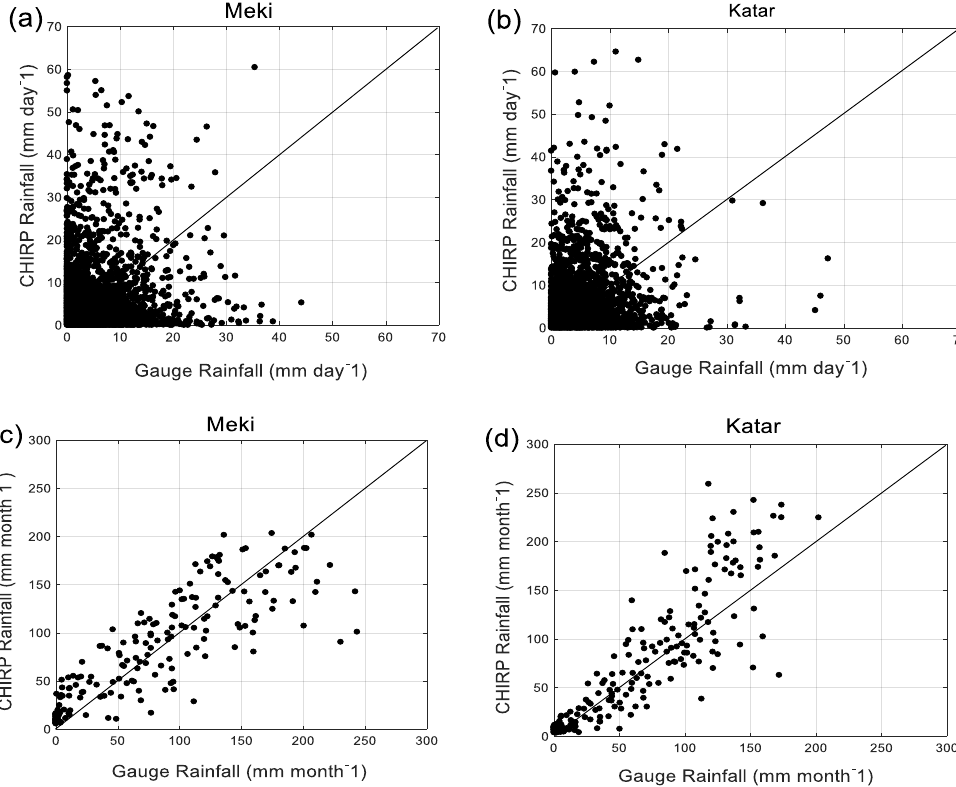
Figure 2. Scatter plots of Climate Hazards Group InfraRed Precipitation (CHIRP) satellite rainfall products against rain gauge rainfall for a time series from 1985–2000, for ( a ) and ( b ) daily at Meki and Katar catchment, ( c ) and ( d ) monthly at Meki and Katar catchments, respectively.